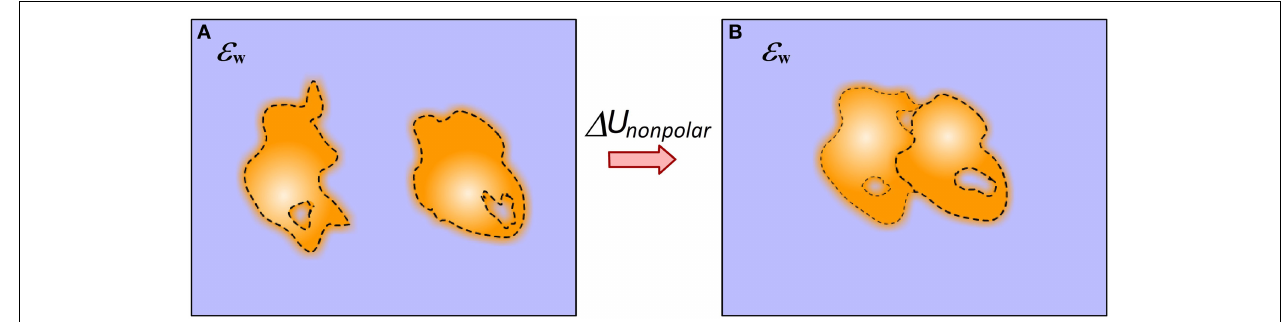
FIGURE 4 | Schematic presentation of the approach of modeling non-polar solvation energy change upon binding. (A) Monomers; (B) Complex. The dash line indicates the smooth transition from protein interior to the water phase. This includes the layer of surface bound water